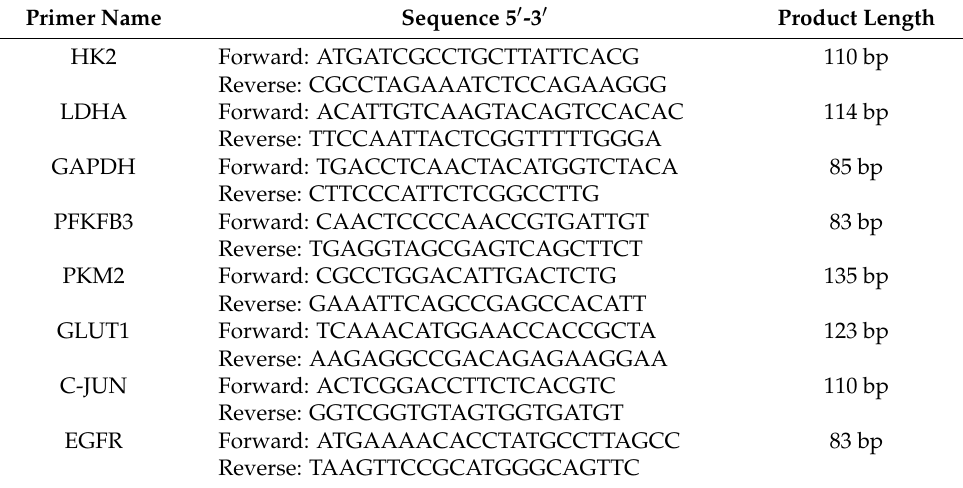
Table 1. Primers which have been used for real time